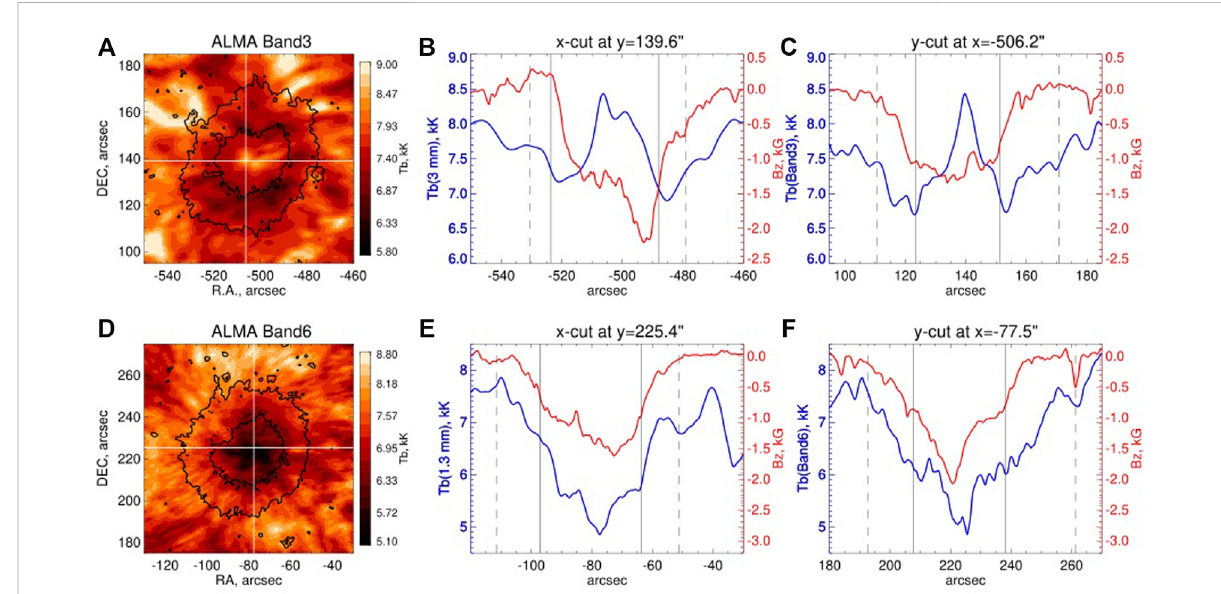
FIGURE 1 ALMA mosaic images of the sunspot in AR 12470 at 3 mm (A) and at 1.3 mm (D) . The color bars correspond to the displayed range of mm brightness. Pro fi les of the mm brightness (blue, left axis) and of the longitudinal component of the magnetic fi eld (red, right axis) for (B) the x-cut at y = 139.6, (C) the y-cut at x = − 506.2 through the brightest umbral pixel at 3 mm; (E) the x-cut at y = 225.4, (F) the y-cut at x = − 77.5 through the darkest umbral pixel at 1.3 mm. The black lines indicate the positions of umbral and penumbral boundaries along the cuts. Adapted from Loukitcheva et al.